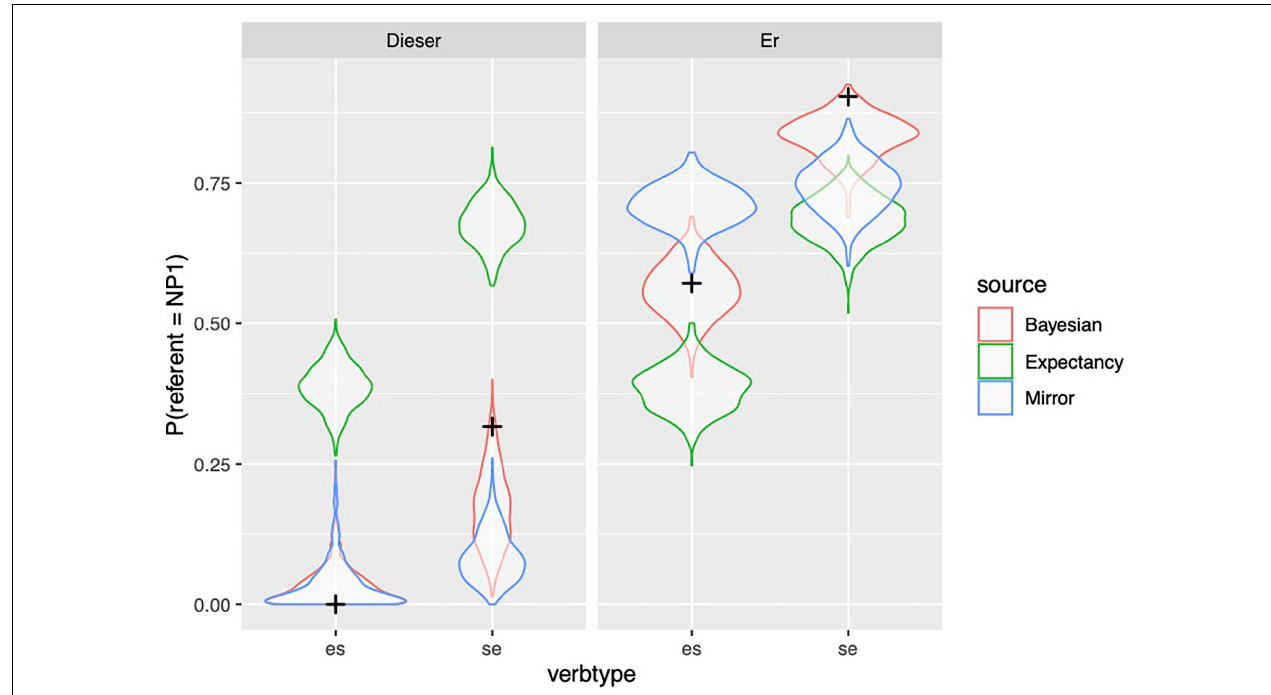
FIGURE 8 | Observed proportion of responses (from held out data, Experiment 2) are depicted with black crosses; distribution of simulated proportions based on the model predictions are depicted with violin plots.